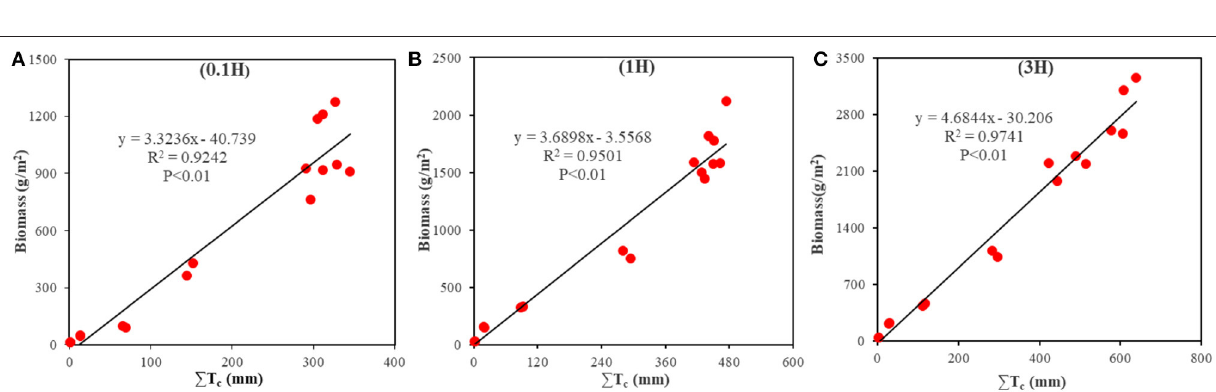
1H, and 3H ( P < 0.01), and the R 2 -values were